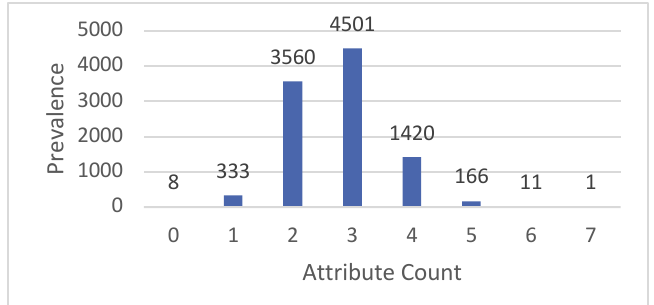
Figure 2: Prevalence of Number of